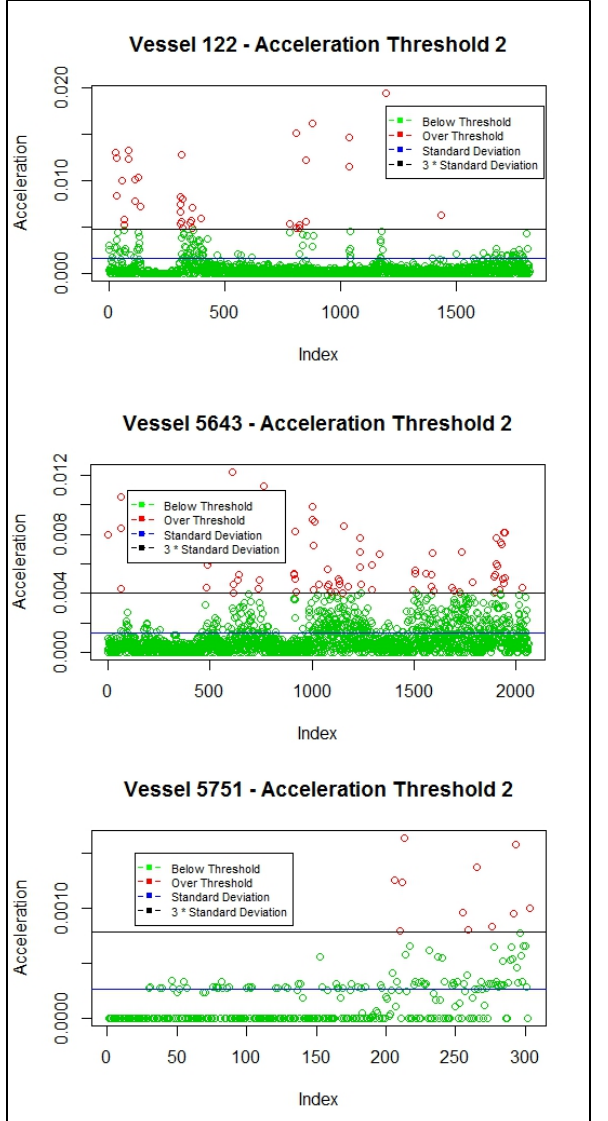
Figure 5 . Distance from Shore Histograms